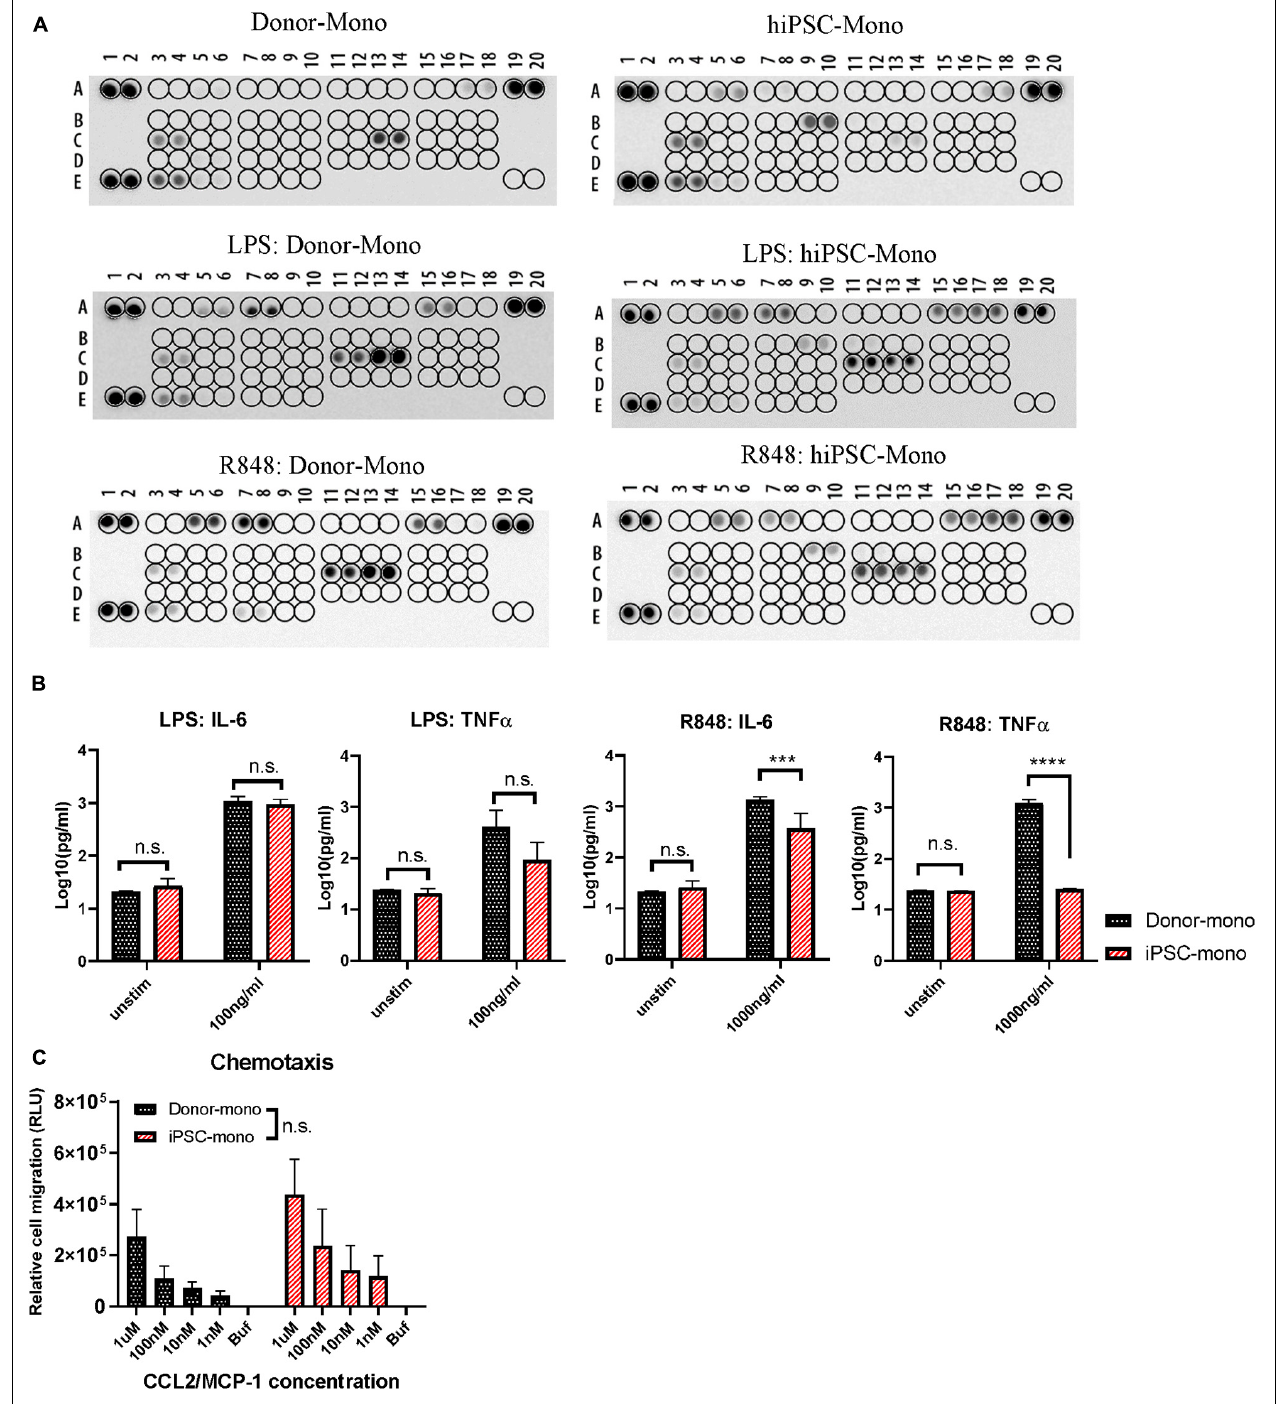
FIGURE 3 | Functional comparison between human induced pluripotent stem cell (hiPSC)- and donor-derived monocytes. (A) Cytokine release signature (A5, A6: CCL2/MCP-1; A7, A8: CCL3/CCL4; A15, A16: CXCL1/GRO α ; A17, A18: CXCL10/IP-10; B9, B10: GM-CSF; C3, C4: IL-1ra/IL-1F3; C11, C12: IL-6; C13, C14: IL-8; E3, E4: MIF/GIF/DER6; E7, E8: TNF α ) detected by Proteome Profiler Array with or without stimuli lipopolysaccharide (LPS) (100 ng/ml) or R848 (1,000 ng/ml) for 24 h in hiPSC- and donor-derived monocytes. (B) ELISA analysis of IL-6 and TNF α secreted by hiPSC- and donor-derived monocytes under unstimulated condition or upon 24 h stimulation of LPS (100 ng/ml) or R848 (1,000 ng/ml), n = 3. (C) Chemotaxis responding to CCL2 at gradient concentration of 1 µ M, 100, 10, and 1 nM in hiPSC- and donor-derived monocytes, n = 3. Two-way ANOVA with Bonferroni correction for multiple comparison: ∗∗∗ p < 0.001, ∗∗∗∗ p < 0.0001.